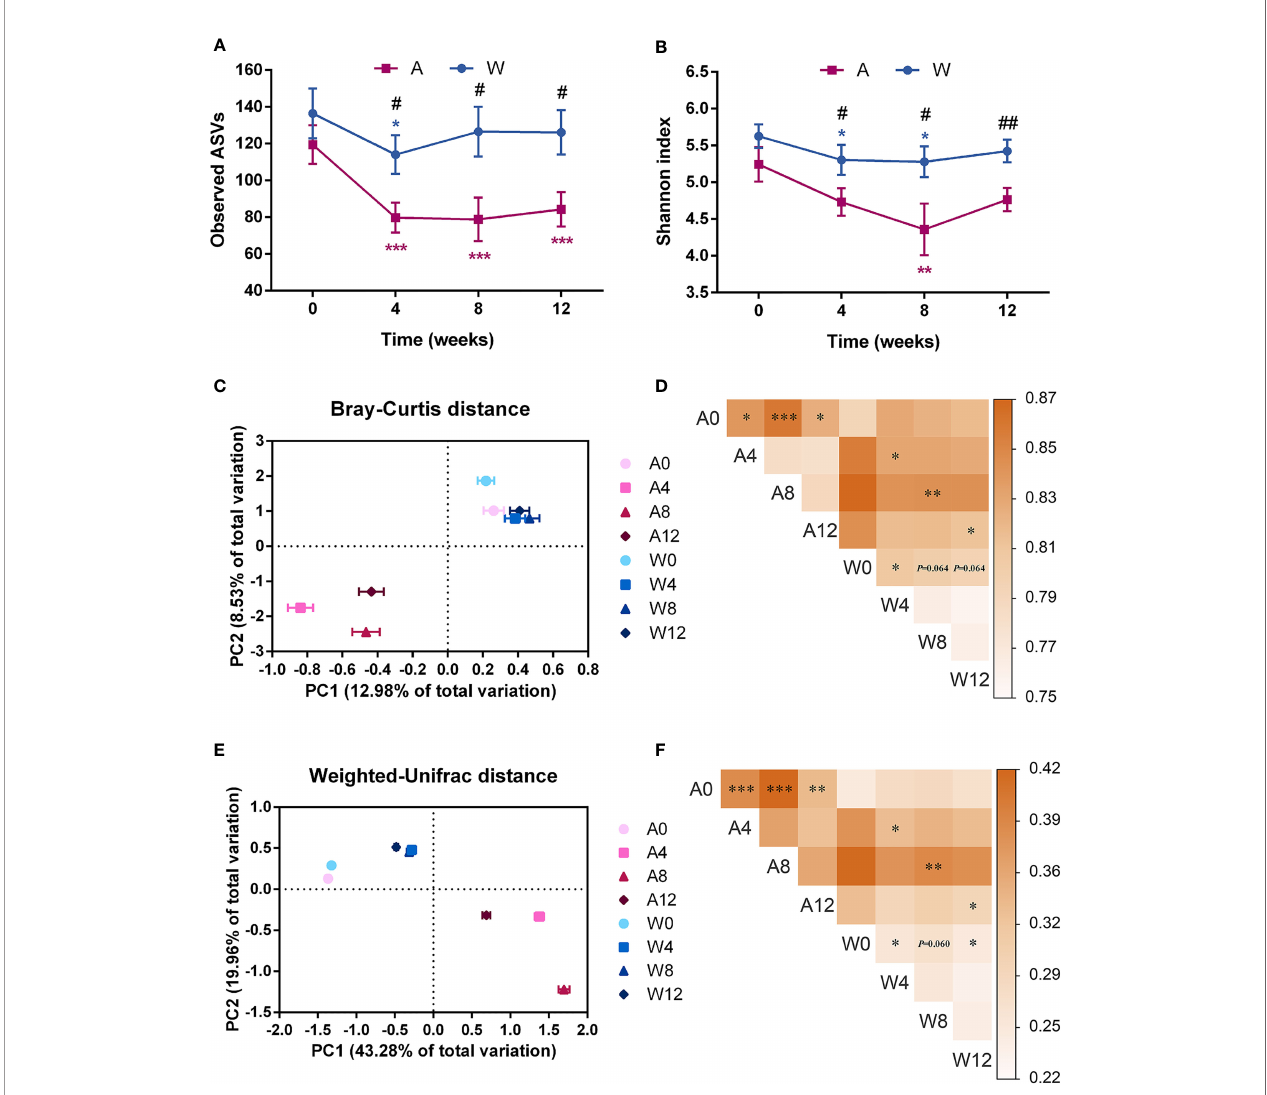
FIGURE 4 | The gut microbial structure was altered in patients with PCOS after the intervention. Alpha diversity measured by (A) observed ASVs and (B) Shannon index. Date expressed as mean ± SEM. * p < 0.05, ** p < 0.01, and *** p < 0.001 for comparison with the week 0 value for the same group, red for A group and blue for W group. # p < 0.05 and ## p < 0.01 for comparison of A group with W group value at the same time point. Principal coordinates analysis (PCoA) performed on the basis of the (C) Bray – Curtis and (E) weighted-Unifrac distances showed the overall changes in gut microbial structure. PC1, principal coordinate 1; PC2, principal coordinate 2. PERMANOVA test was performed on the basis of the (D) Bray – Curtis and (F) weighted-Unifrac distances. The colors of the blocks indicate the distance, and the asterisks denote signi fi cant difference between two time points or different groups. * p < 0.05, ** p < 0.01, and *** p < 0.001. A0, A4, A8, and A12: weeks 0, 4, 8, and 12 in the A group; W0, W4, W8, and W12: weeks 0, 4, 8, and 12 in the W